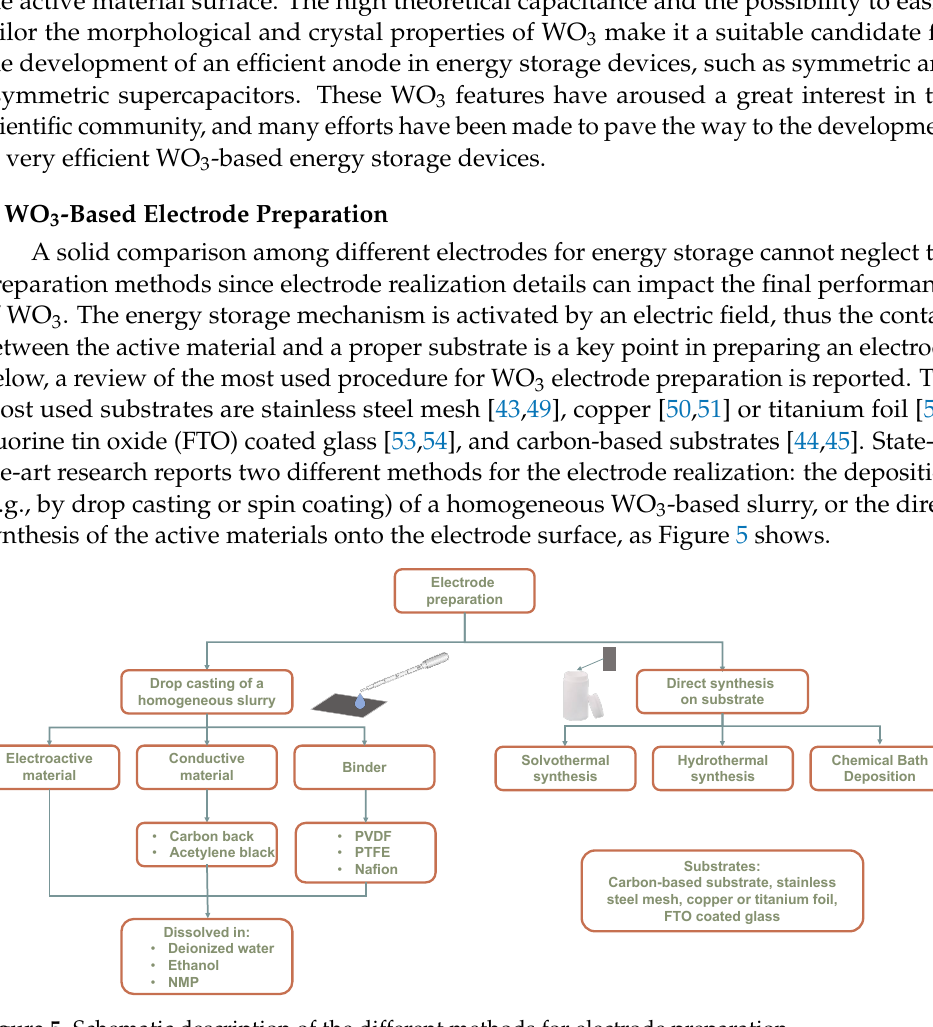
Figure 5. Schematic description of the different methods for electrode